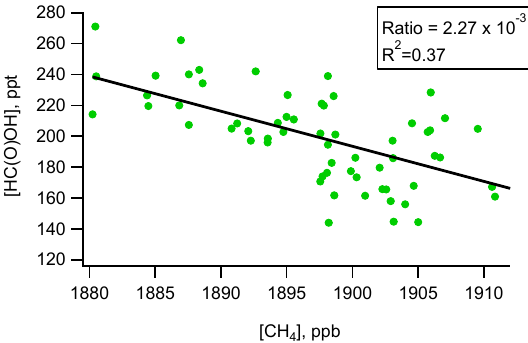
Figure 8. The relationship between the concentrations of HC(O)OH and CH 4 , along transect x during flight B796b on 16 August 2013.